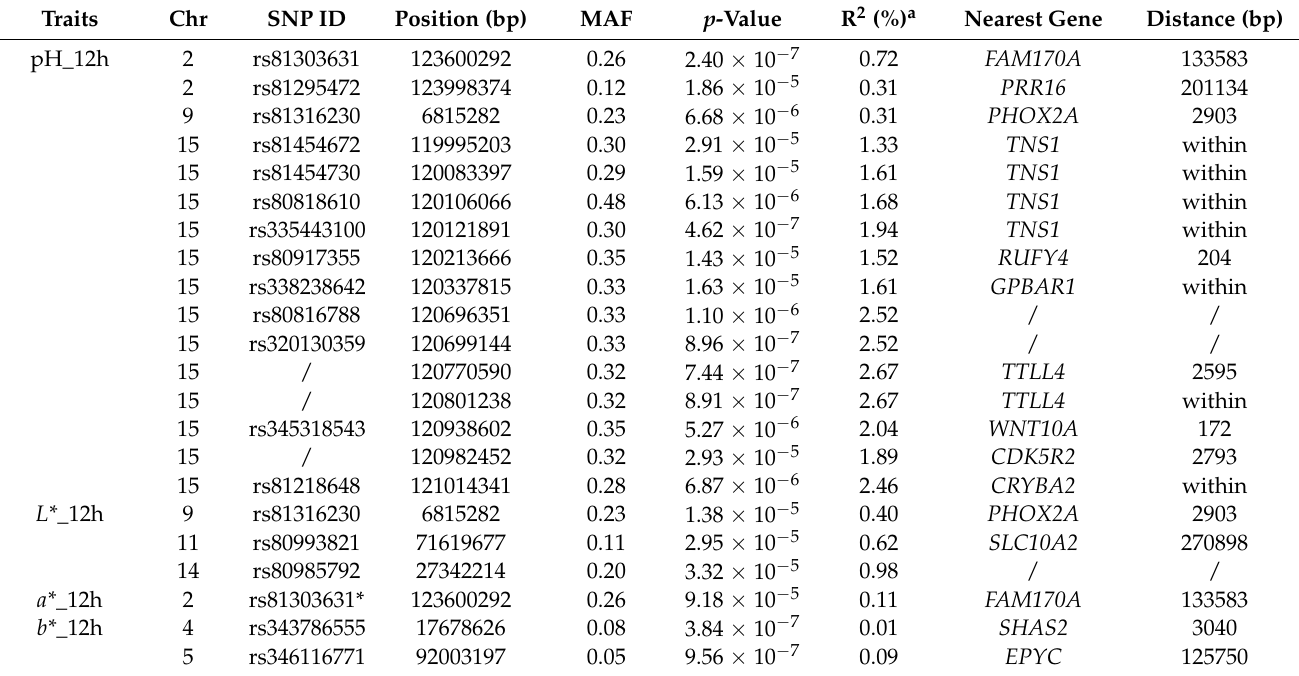
Table 3. Significant SNPs associated with meat quality traits (12 h) in DLY